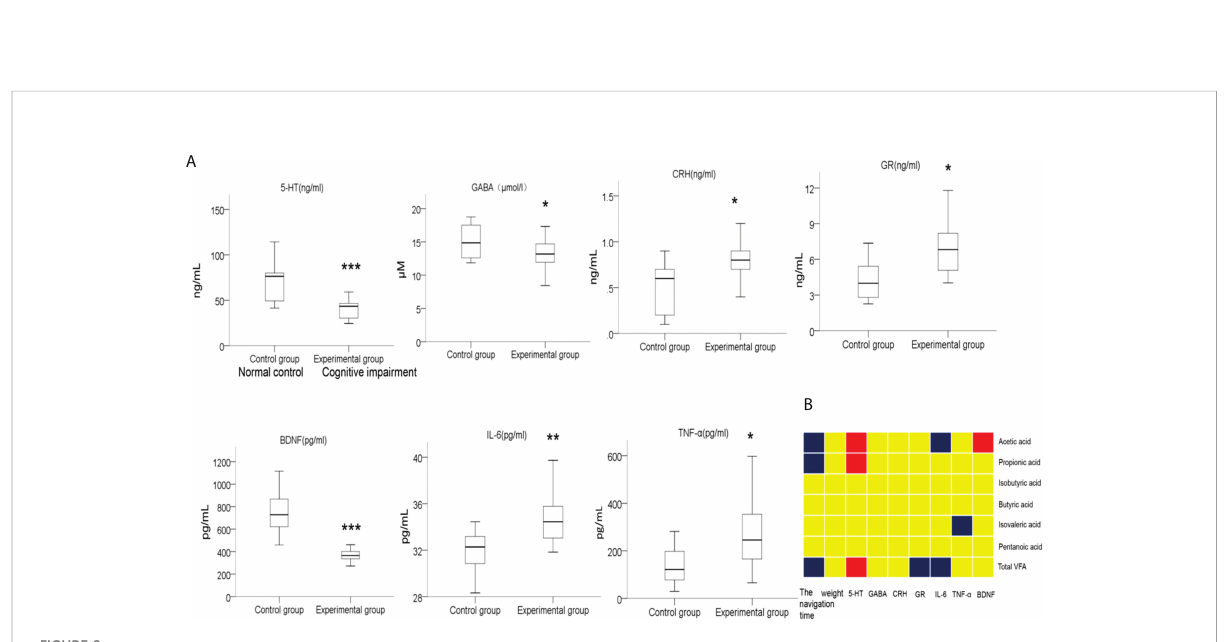
FIGURE 8 Comparison on the levels of serum factors between two groups of rats, and the correlations between the levels of these serum factors and the abundances offecal SCFAs. (A) Blood samples were collected after the MWM tests from the rats in the normal control group and the cognitive impairment group. The levels of 5-HT, GABA, BDNF, GR, CRH, IL-6, and TNF- a in serum samples were determined by ELISA. n = 10 for the normal control group; n = 21 for the cognitive impairment group; * P < 0.05, ** P < 0.01, *** P < 0.001, between the two groups. (B) The correlations between the abundances of total fecal SCFAs or the indicated speci fi c SCFAs and the levels of serum factors, navigation duration, and rat body weight were analyzed, and the results are shown in the block chart. Red, positive correlation; blue, negative correlation; yellow, no